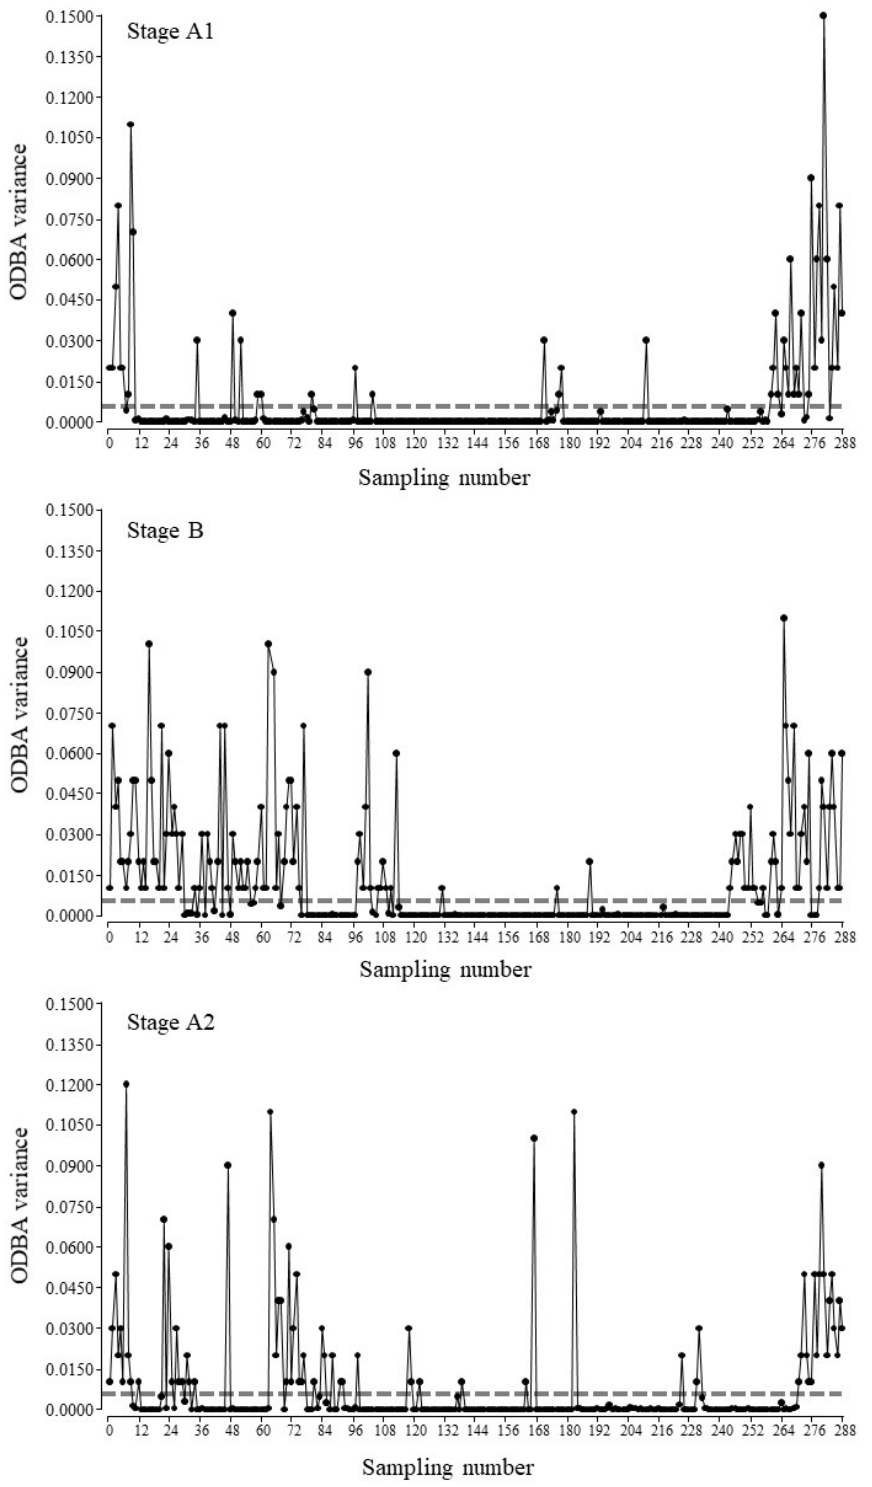
Figure 9. Activity pattern of individual Tamandua tetradactyla (as an example) exposed to semi-controlled conditions in response to enclosure complexity. Experimental stages: during A1 and A2, lesser anteaters were in the complex environment, and during B, they were in the enclosure with reduced complexity. ODBA variance was calculated for each sampling point (90 records/sampling; 12 samplings/hour). The horizontal dotted line indicates the threshold value to discriminate active behaviours from inactive ones.